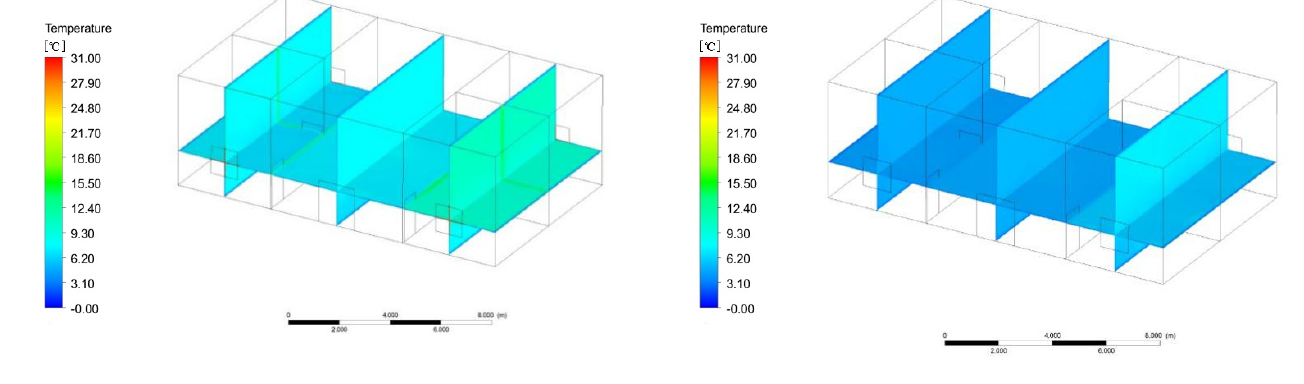
Figure 11. Cooking and heating at defined times; * refers to heating without solar radiation. With the closure of the fire wall cooking system, the indoor temperature began to slowly drop. Within 30 min of stopping cooking, the indoor temperature was in a stable state. The temperature of the first and second floors on both sides of the fire wall was still maintained at 14.6 °C, and the temperature in the other rooms was maintained at 9.8 °C.